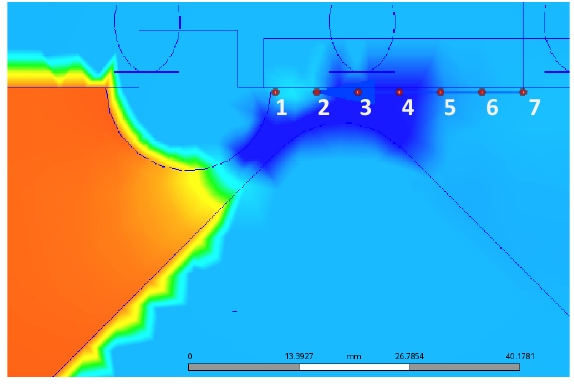
Fig. 5. Measurement points